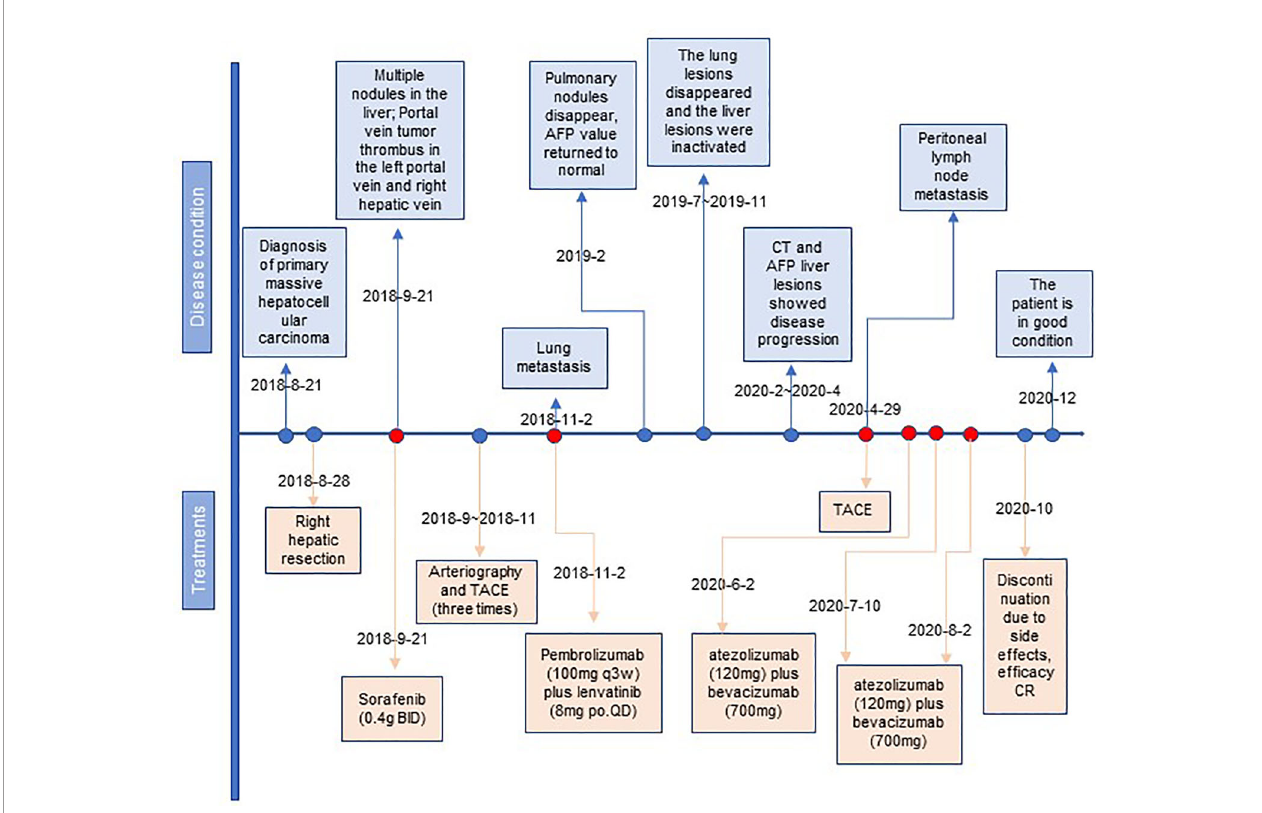
FIGURE 4 | The timeline with therapy and disease status. HCC, hepatocellular carcinoma; TACE, transcatheter arterial chemoembolization; CR, complete